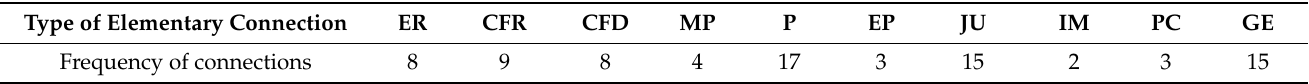
Table 3. Types of elementary connections identified in study